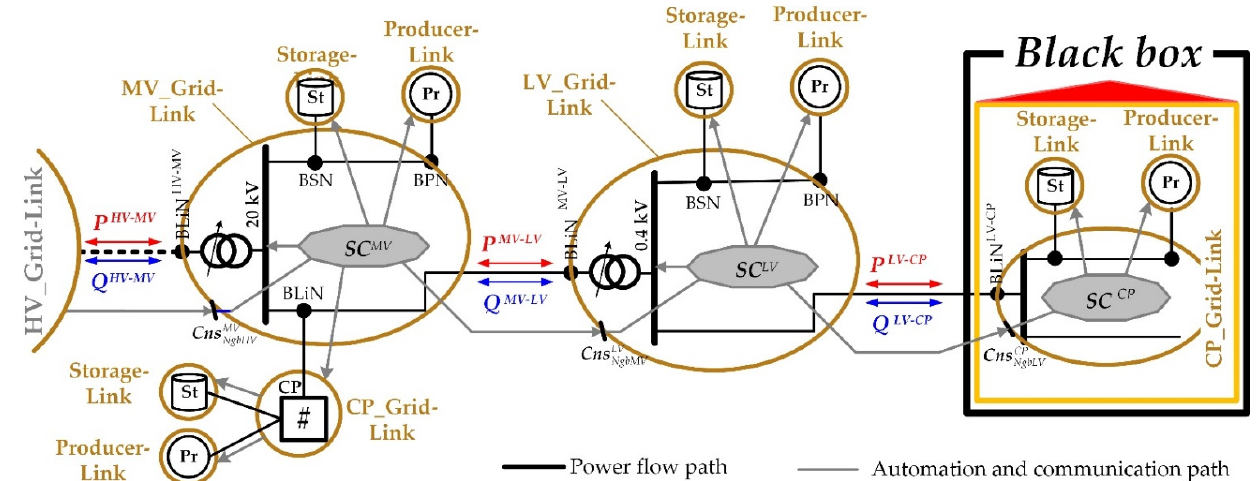
Figure 5. Structure of the vertical link chain.